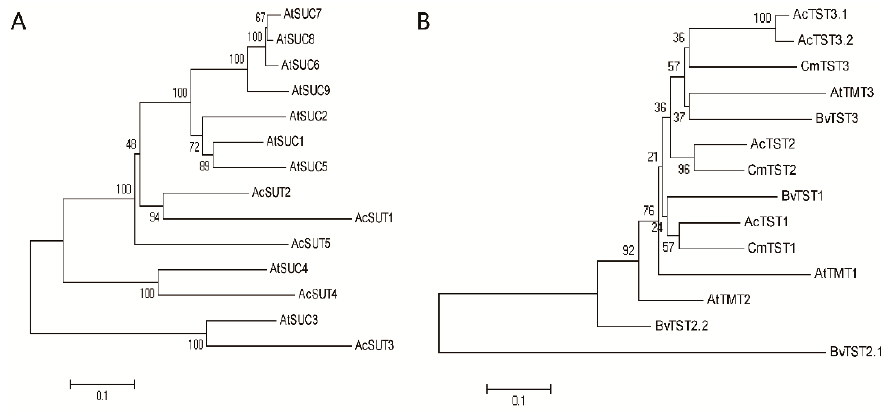
Figure 5. Phylogenetic tree of amino acid sequences of SUTs and TSTs in Actinidia chinensis and other species. ( A ) SUTs; ( B ) TSTs. Trees were constructed by the neighbor-joining method based on amino acid differences (p-distance) using the MEGA 7.0 program with complete deletion and 1000 bootstrap replicates. Accession numbers were as follows: Arabidopsis , AtSUC1-9 (At1g71880, At1g22710, At2g02860, At1g09960, At1g71890, At5g43610, At1g66570, At2g14670, and At5g06170), AtTMT1-3 (At1g20840, At4g35300, and At3g51490); Beta vulgaris , BvTST1 (XP_010686712.1), BvTST2.1 (XP_010678631.1), BvTST2.2 (XP_010690557.1), and BvTST3 (XP_010680636.1); Cucumis melo , CmTST1 (XP_008464819.1), CmTST2 (XP_008448165.1), and CmTST3 (XP_016899284.1); A. chinensis (shown in